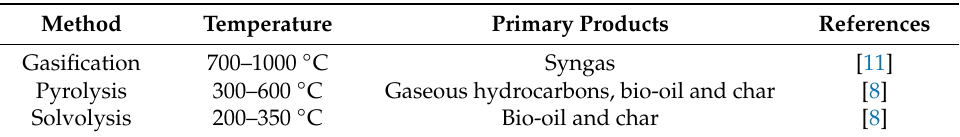
Table 1. Temperatures and primary products from di ff erent depolymerization methods used in lignin